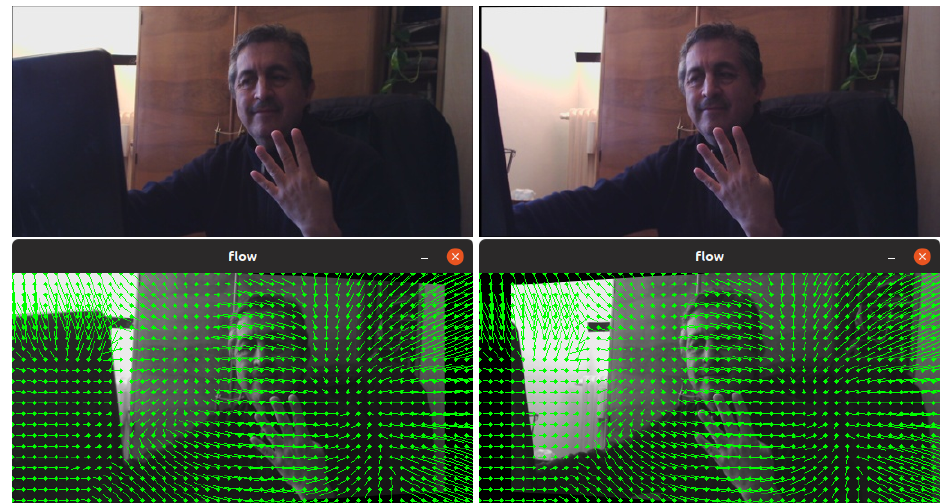
Figure 1. Left (L) and right (R) views (that will form 0–31 frames by morphing) of a stereoscopic image. The morphed displacements vectors of the optical flow data are also shown.